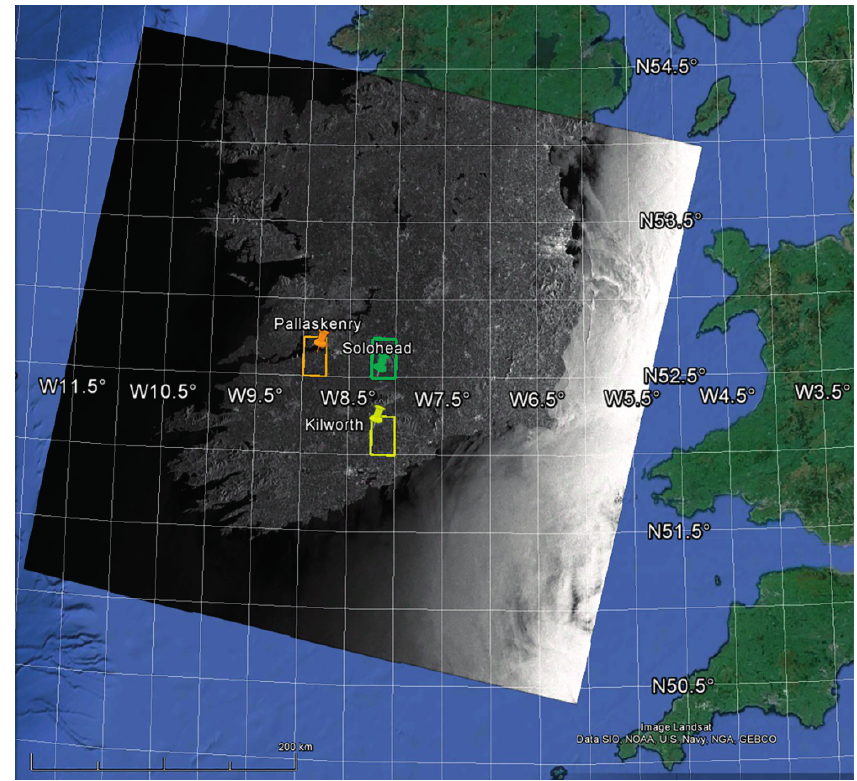
Figure 1. ASAR WS image of the area under study. The location of each in situ station used in this work is also shown within each Essential Climate Variable (ECV)-sized pixel ( © Google